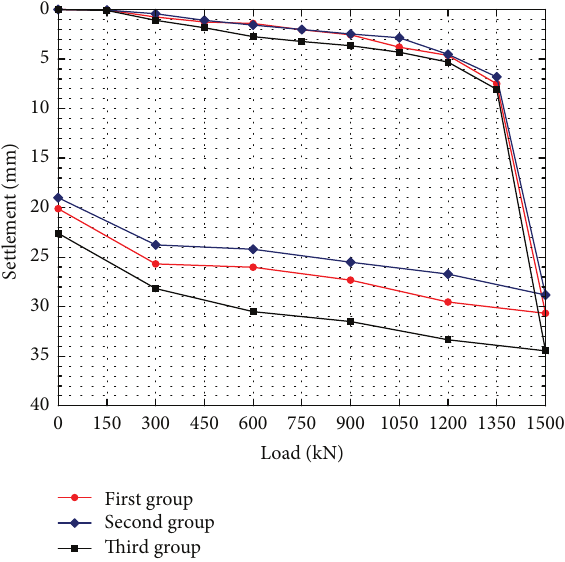
Figure 5: The 𝑄 - 𝑆 curve of single CFG pile.